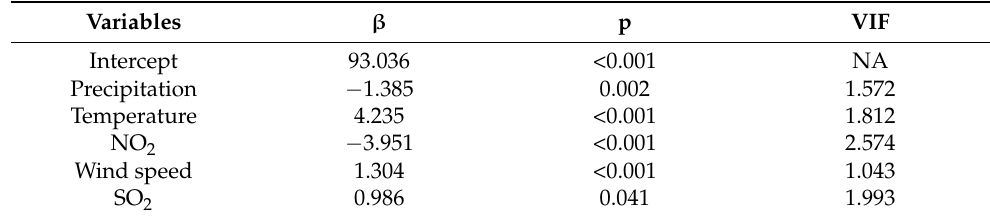
Table 3. Four -year average GWR model of O 3 concentration based on 81 monitoring sites. Table 3. Four-year average GWR model of O 3 concentration based on 81 monitoring sites. Variables Variables